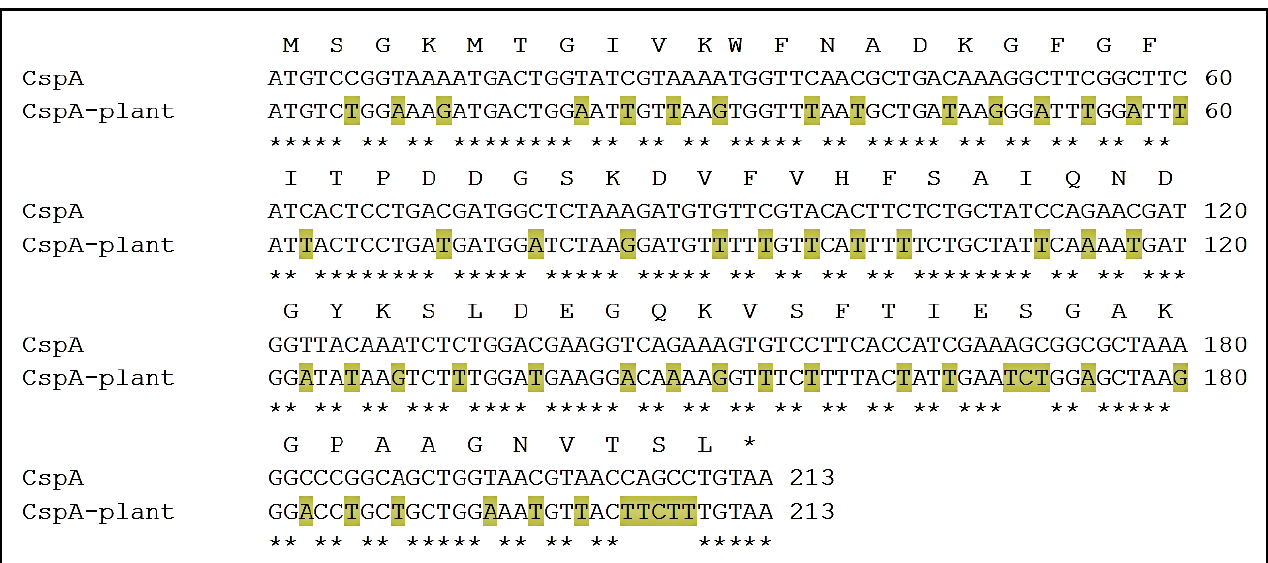
Figure 2. Alignment of the nucleotide sequences of the native cspA gene and the cspA gene with the optimized codon composition. The 55 substitutions (marked in yellow) were made in the cspA gene nucleotide sequence; the percent identity of the original and modified nucleotide sequences was 74%, and the identity of the codons was 32%.